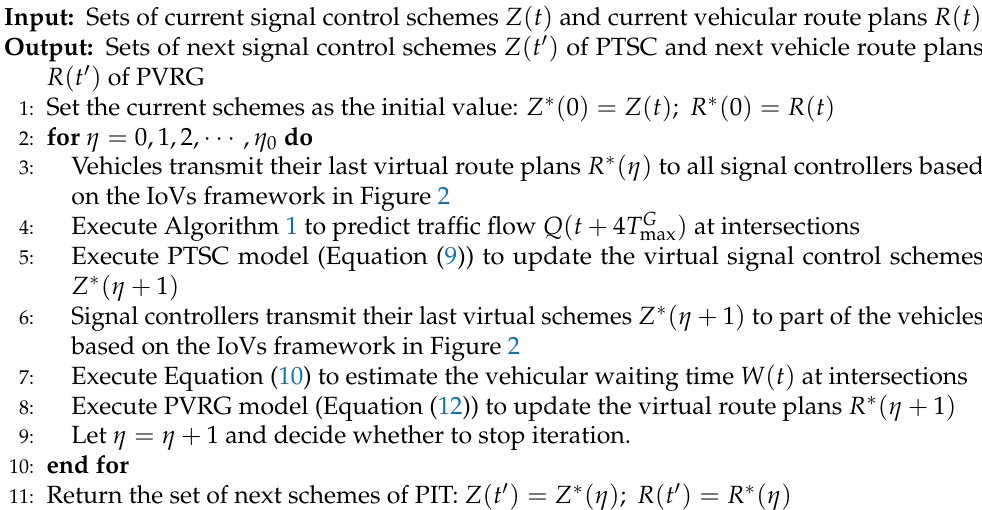
Algorithm 2 Pseudo-code of our updating distributed algorithm for solving proposed PIT